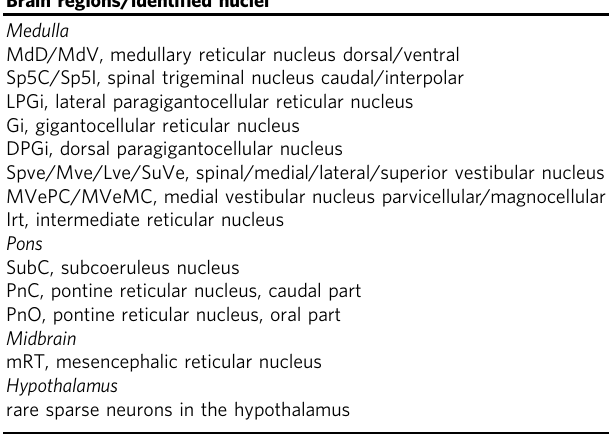
Brain regions/identi fi ed